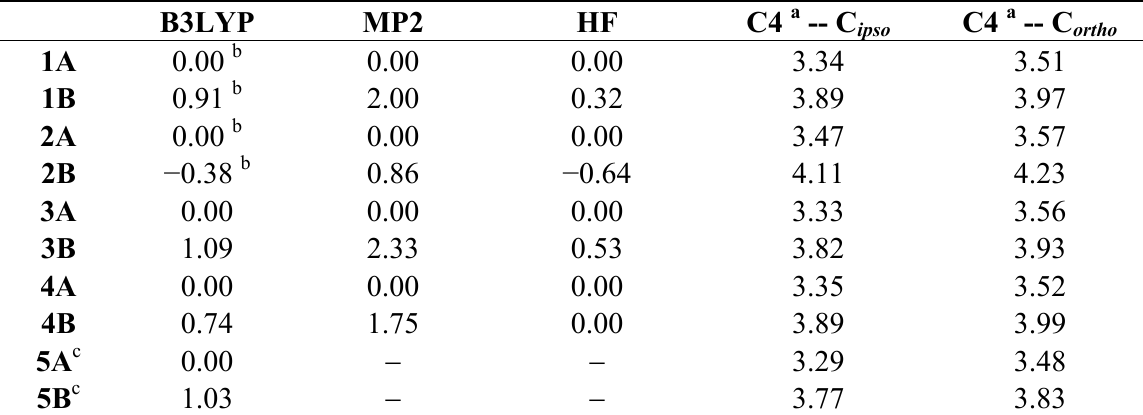
Table 1. Relative electronic energies (kcal/mol) and non-bonded interatomic distances (Å) for conformers A and B of 1 – 5 .